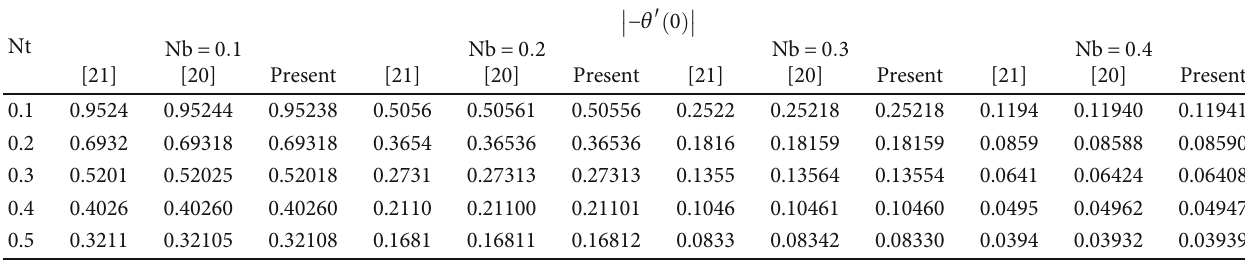
Table 4: Comparison of the values of the Nusselt number with Pr = Sc = 10 .